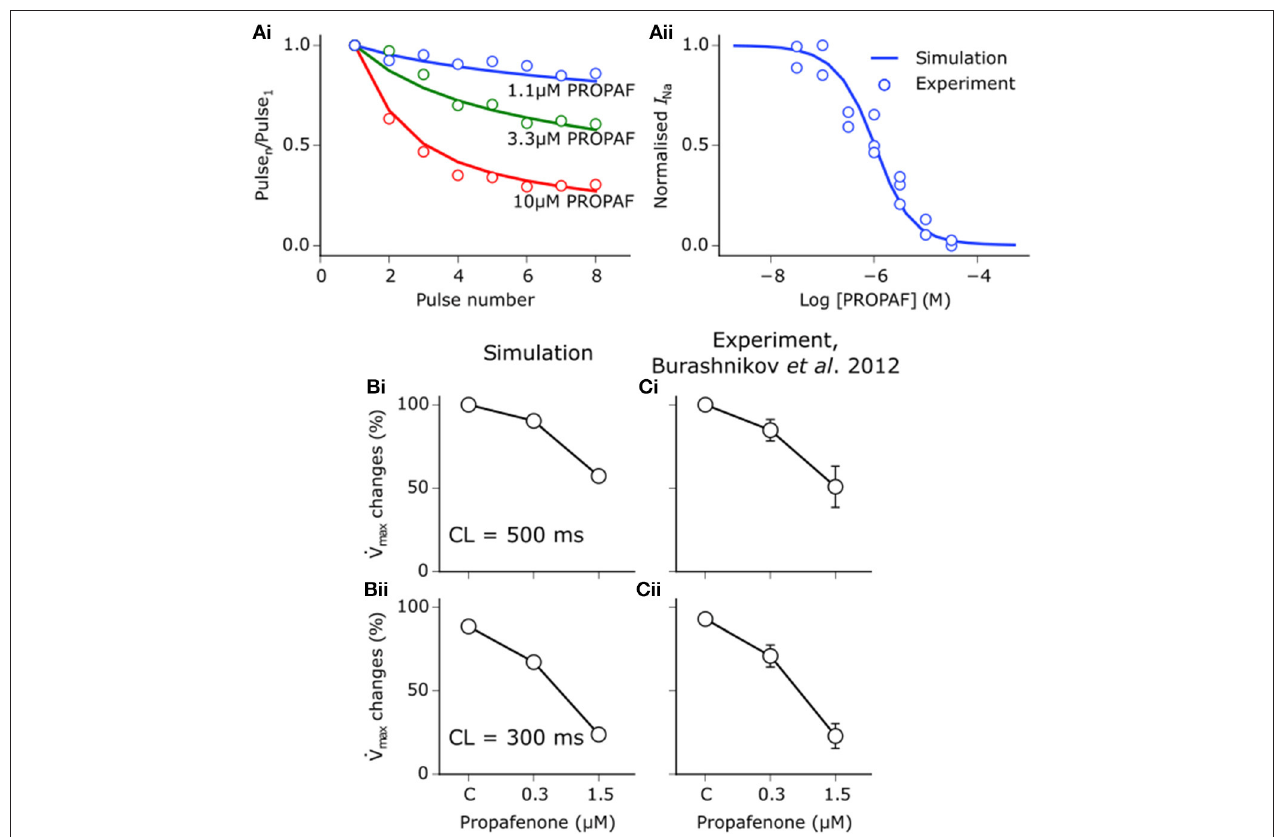
FIGURE 2 | Propafenone interactions with sodium channels. (Ai) Simulated (solid lines) and experimental (points) use-dependent block of sodium channels by propafenone (PROPAF) elicited using a series of 8 pulses from − 90mV to 0mV at 3Hz for three different test concentrations. (Aii) Steady state block of sodium channels using pulses from − 90mV to 0mV at 3Hz until a steady state was achieved. Experimental data are taken from Harmer et al. (2008), where the steady state block IC 50 value is given as 1.4 µ M. (B) Simulated and (C) experimentally-measured PROPAF-induced reduction in maximum upstroke velocity ( ˙ V max ) upon application of 0.3 and 1.5 µ M PROPAF at a cycle length (CL) of (i) 500ms and (ii) 300ms. All ˙ V max reductions are relative to the control (C) value at a CL of 500ms. Experimental data, recorded from canine atrial myocytes, are taken from Burashnikov et al.